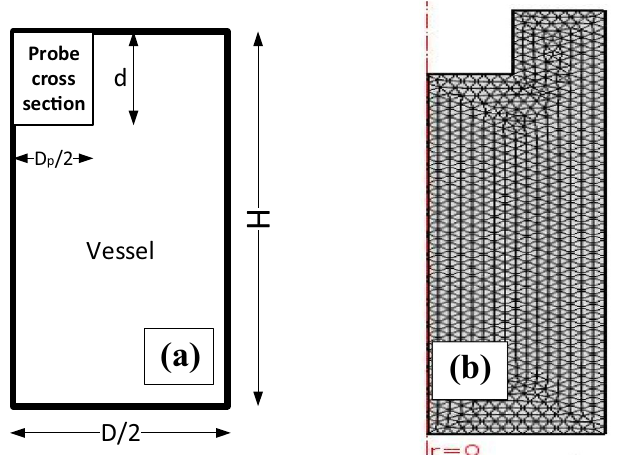
Figure 1. Sonicator and vessel simulation: ( a ) schematic of ultrasonic processing cell with sonotrode (ultrasonic probe of diameter D p , immersed depth of probe d, ultrasonic processing cell of diameter D and the height of the liquid inside the cell H); ( b ) scheme of the mesh used for simulation.